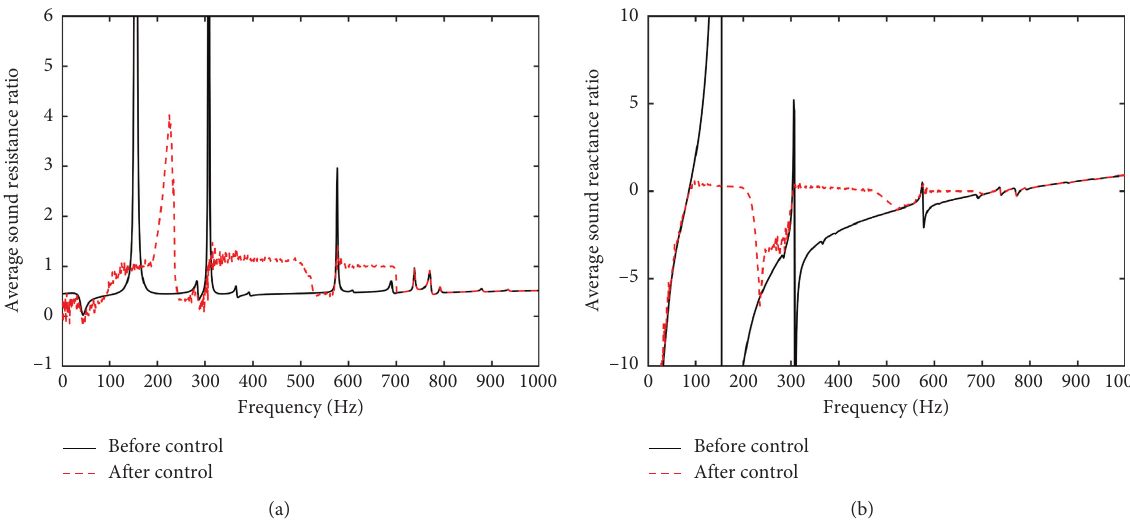
Figure 5: Surface average impedance ratio of the active MPPA before and after control: (a) sound resistance ratio and (b) sound reactance